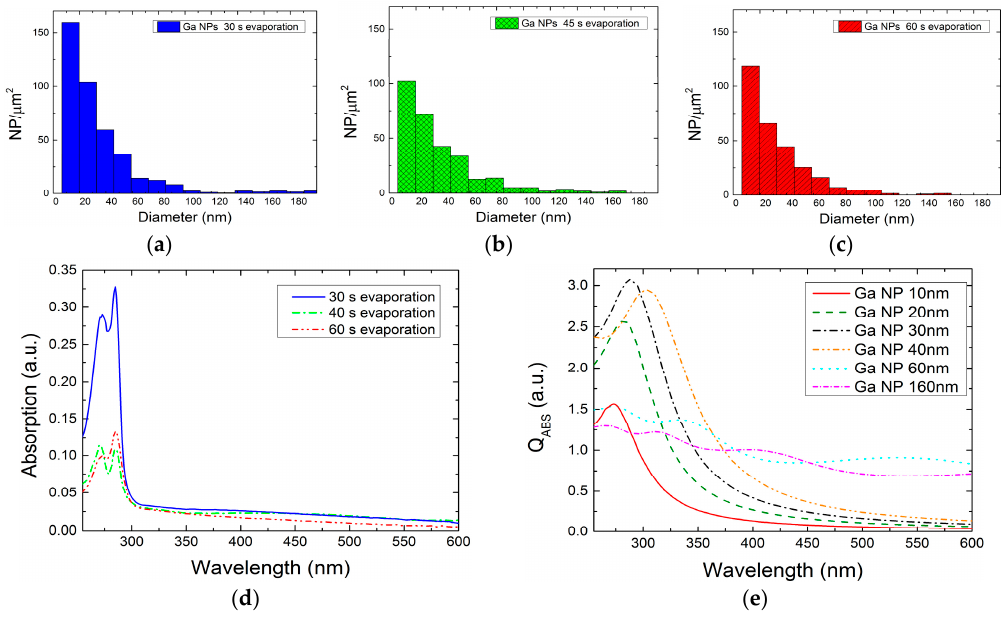
Figure 6. Ga NP distributions for ( a ) 30 s; ( b ) 45 s and ( c ) 60 s evaporation time; ( d ) The optical absorption was measured after colloidal preparation in THF; ( e ) Numerical simulation of the absorption efficiency (QABS) in structures with different diameters was carried out in order to find a relationship between the measured spectra and the NPs distributions.